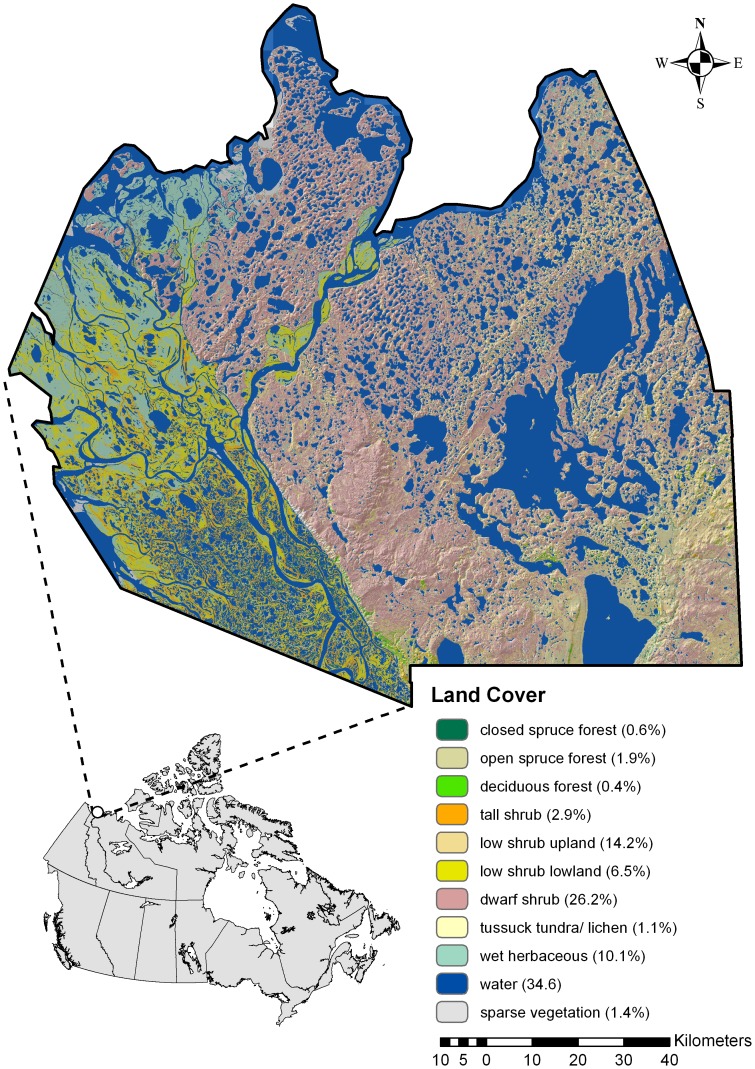
The Mackenzie Delta study area showing distributions for 11 covers, along with percentages.Lower left inset shows study area location within Canada.